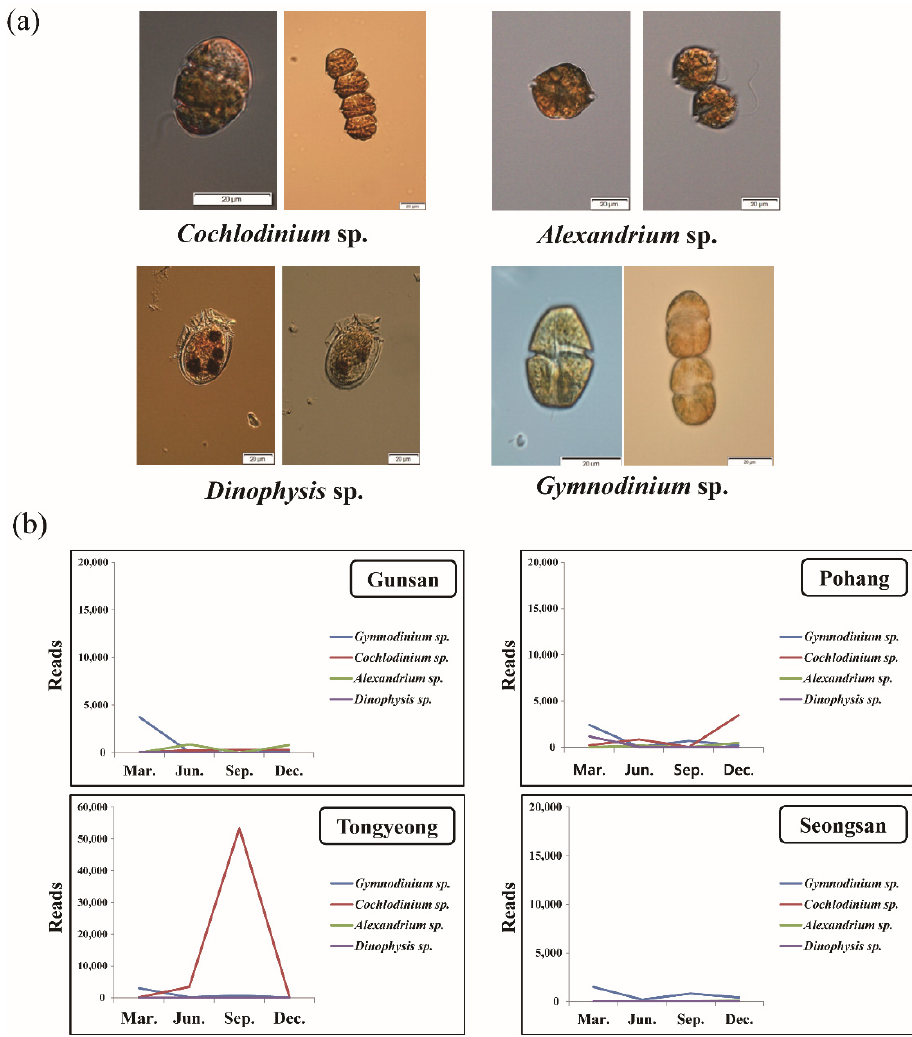
Figure 5. Seasonal distribution of red-tide-causing species through metagenome analysis. Photo of red-tide-causing species ( Cochlodinium sp., Alexandrium sp., Dinophysis sp., Gymnodinium sp.) taken under a light microscope ( a ), seasonal changes in red-tide-causing species ( b ).